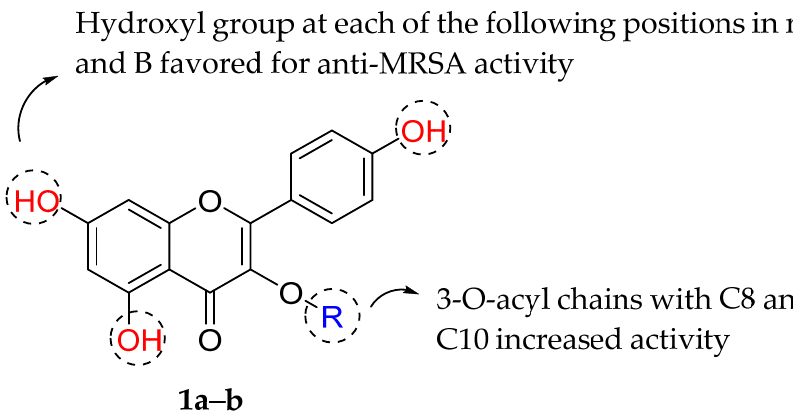
Table 1. Isolated compounds from Laurus nobilis were shown to demonstrate potent antibacterial activity against MRSA strains.